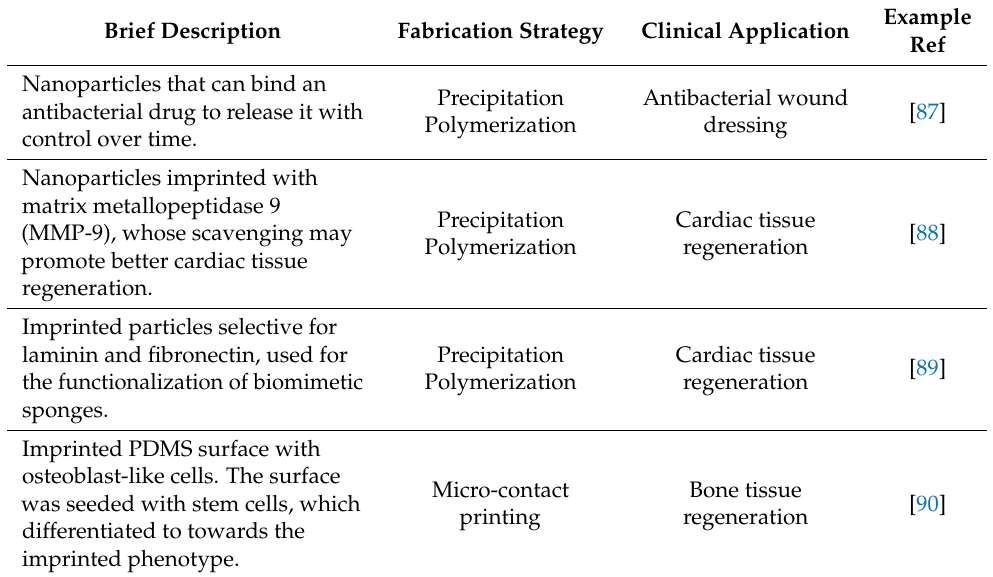
Table 2. Examples of the translation of MI to TE, alongside the clinical application of the specific case. Brief